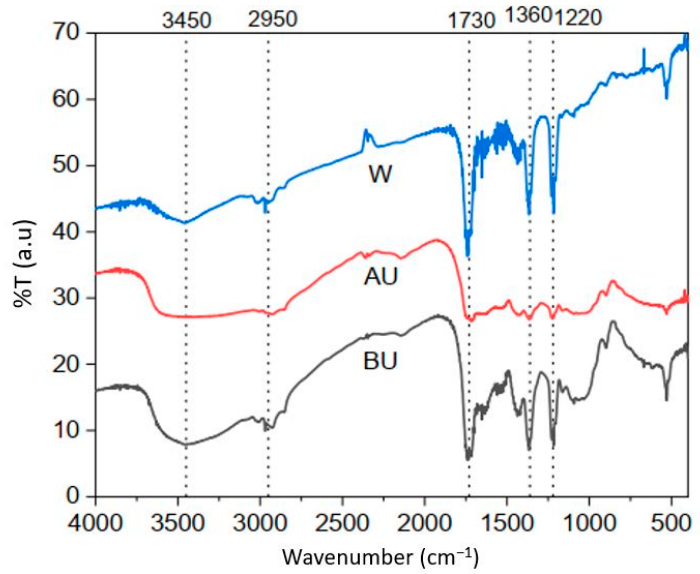
Figure 1. FT-IR spectra of pure garlic peel (BU), after adsorption of EBT garlic peel (AU) and washed after use garlic peel (W). after use garlic peel